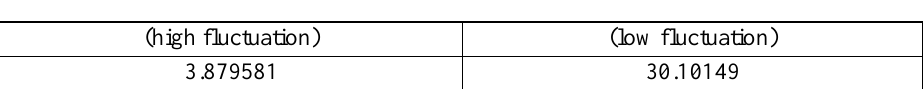
Table 13: Results of the investigation of structural failure in the liquidity time series